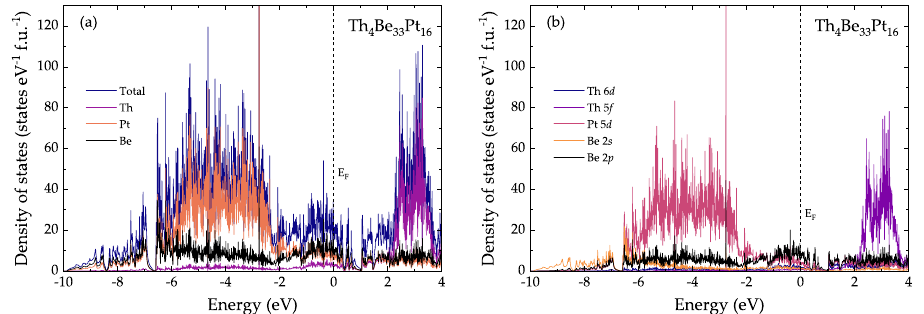
Figure 6. Computed electronic density of states at the fully-relativistic level for Th 4 Be 33 Pt 16 : total and atom- resolved density of states (left), as well as projected density of states showing the contributions of the most relevant orbitals